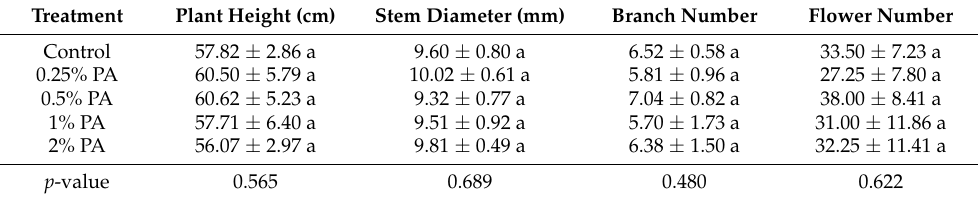
Table 1. Morphological response of tomato ‘Scotia’ plants treated with pyroligneous acid (PA).